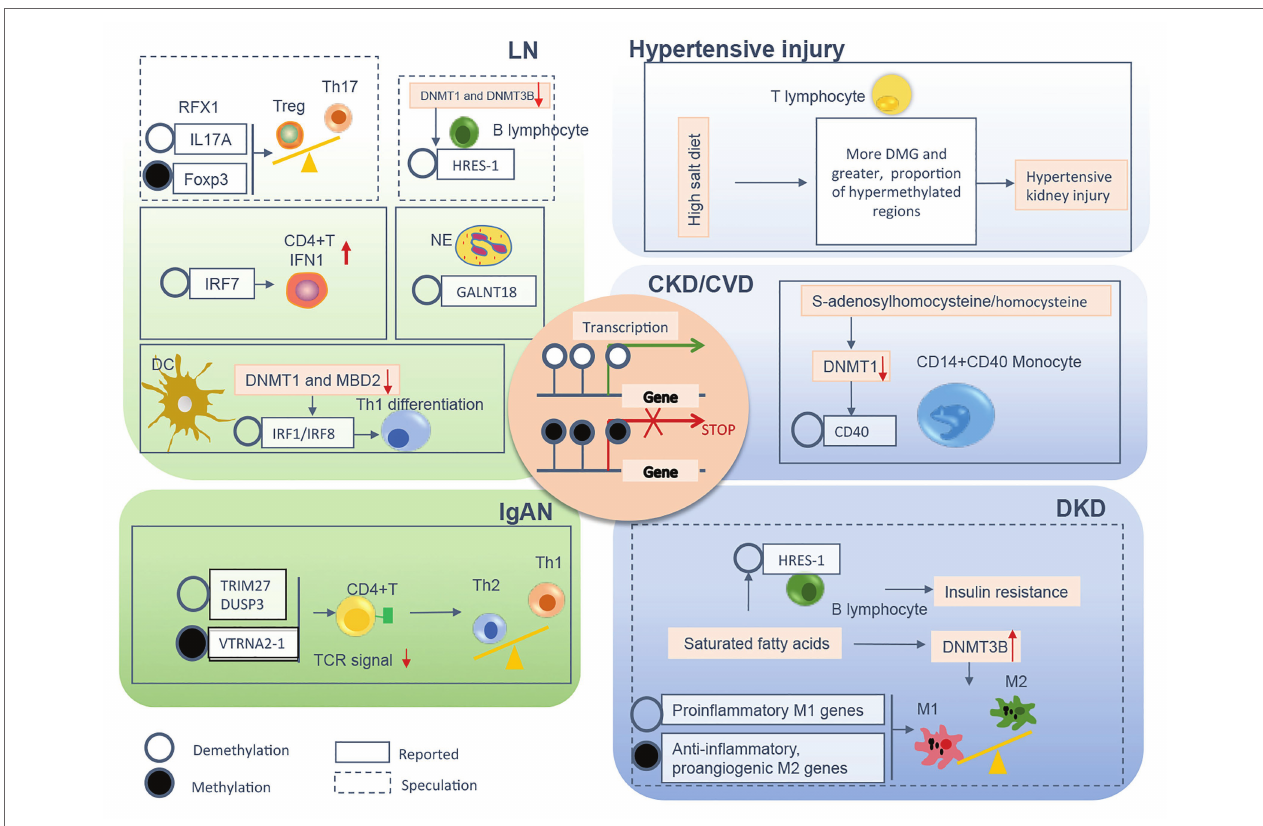
FIGURE 2 | The relevant DNA methylation profiles in immune cells from CKD patients are summarized by different chronic pathogenic conditions, including LN, IgAN, hypertensive kidney injury, DKD, and uremia. Demethylation or methylation of certain genes regulates immune cell phenotype shift/differentiation, or pro/anti- inflammation signal, therefore contributes to uncontrolled kidney inflammation and CKD progression. The mechanism boxed off with solid lines is documented in CKD with different etiology, whereas the one with dashed lines is speculated to relate to the development of kidney diseases founded on circumstantial evidence. CKD, chronic kidney disease; LN, lupus nephrites; IgAN, IgA nephropathy; DKD, diabetic kidney disease; CVD, cardiovascular disease; Treg, regulatory T; Th, T helper; NE, neutrophil; DC, dendritic cell; TCR, T cell receptor; M1, classically activated macrophage; M2, alternatively activated macrophage; IFN, interferon; Foxp3, forkhead box P3; DNMT, DNA methyltransferase; MBD, methyl-CpG binding domain; RFX, regulatory factor X; HRES-1, human T cell lymphotropic virus-related endogenous sequence-1; IRF, interferon regulatory factor; GALNT18, polypeptide nacetylgalactosaminyltransferase 18; TRIM27, tripartite motif-containing 27;